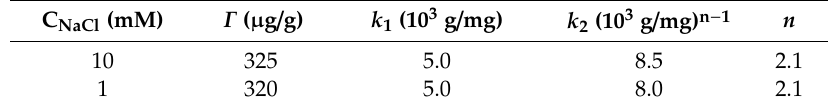
Figure 10. Adsorption isotherms of lindane onto SDS-modified nano-aluminum hydroxide (SMNAH) at two NaCl concentrations. The points are experimental data and solid lines are fitted by a two-step adsorption model. Error bars indicate the standard deviations of three replicates. Table 2. The fit parameters for lindane adsorption isotherms onto SDS modified nano-aluminum hydroxide (SMNAH).